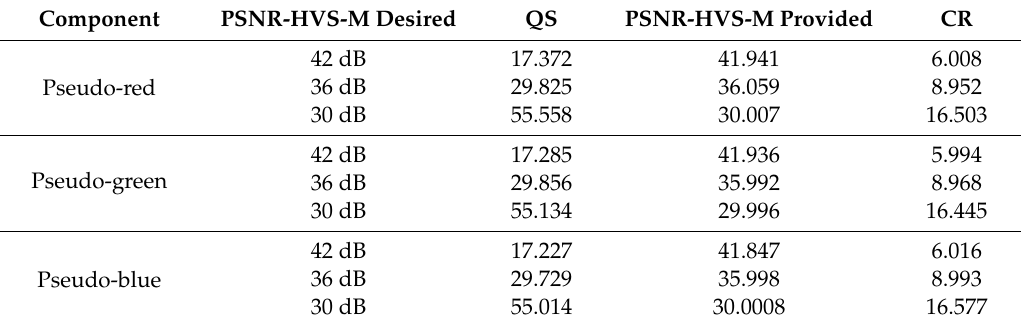
Table 13. Compression parameters.